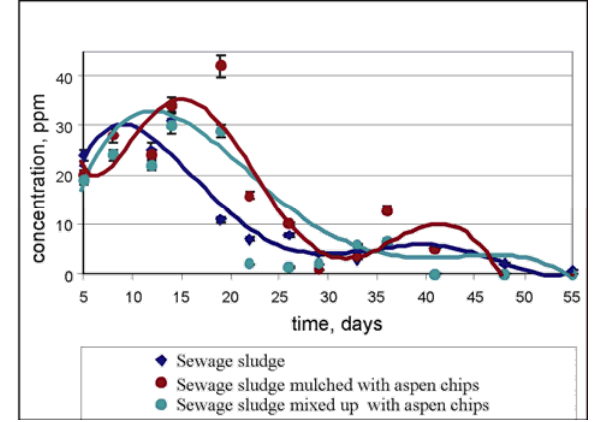
Fig. 12. Hydrogen sulphide emissions during composting sew- age sludge with ash-tree bark